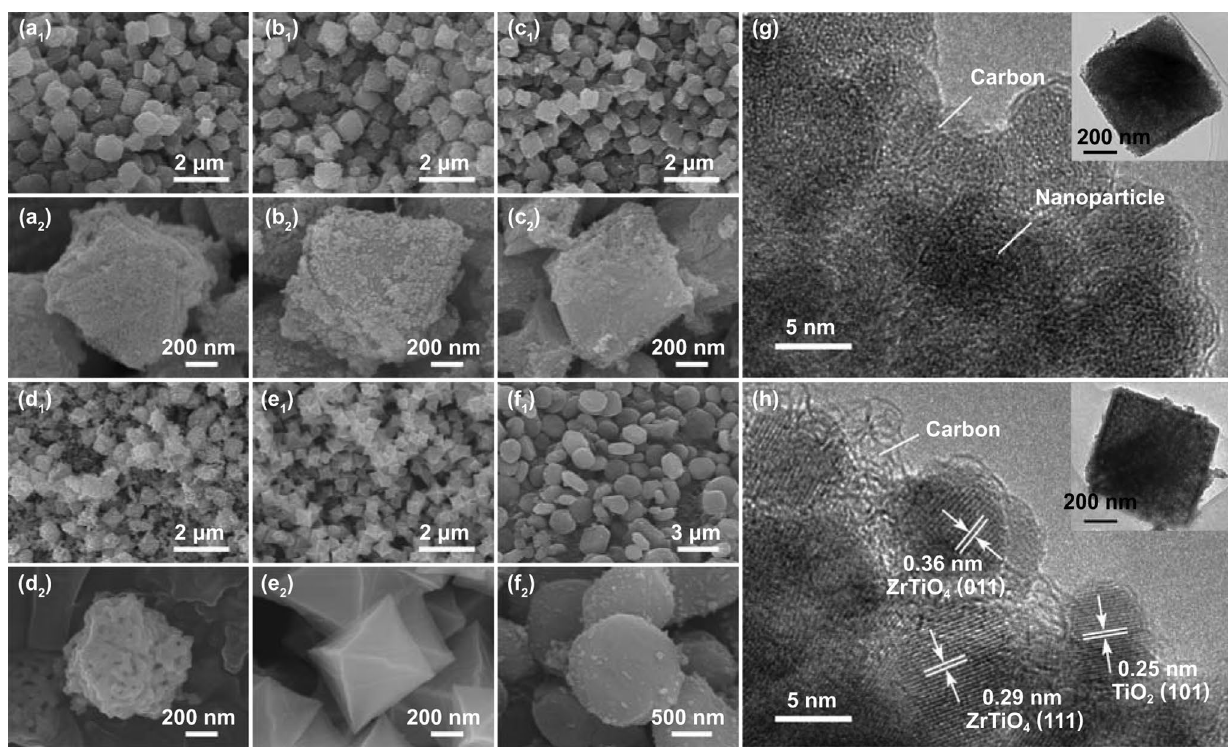
Fig. 4 SEM images of a TZC-6, b TZC-7, c TZC-8, d TZC-9, e ZC-7, and f TC-7. HR-TEM images of g TZC-7, and h